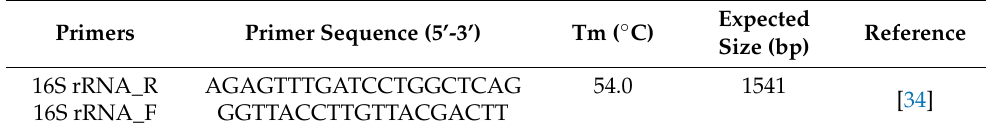
Table 2. Primers used in PCR amplification of 16S